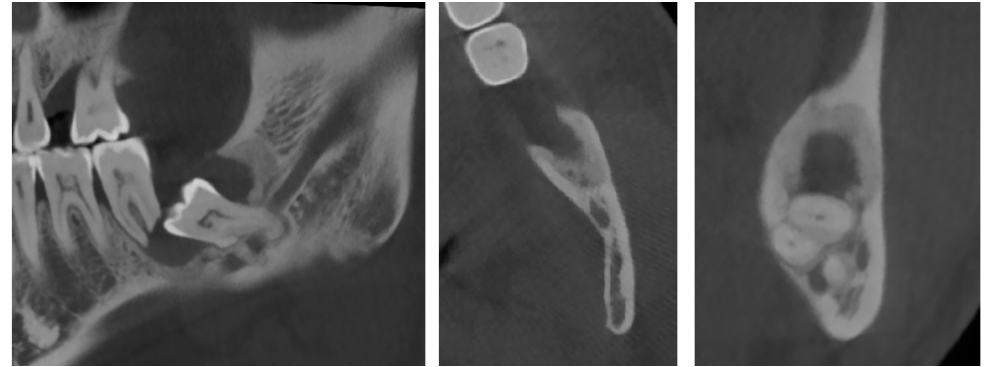
Figure 9. CBCT X-ray of the case #3